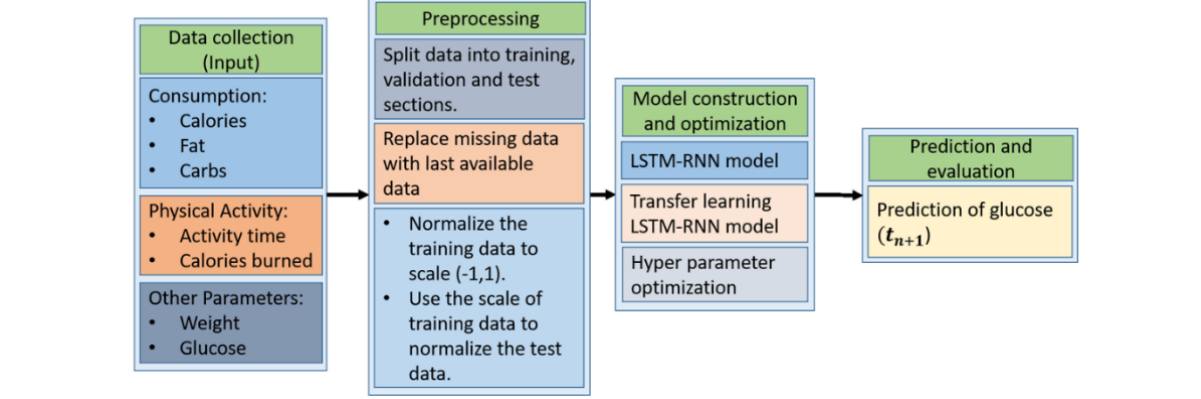
Figure 1. General scheme of the proposed method of predicting blood glucose level. LSTM-RNN: long short-term memory recurrent neural